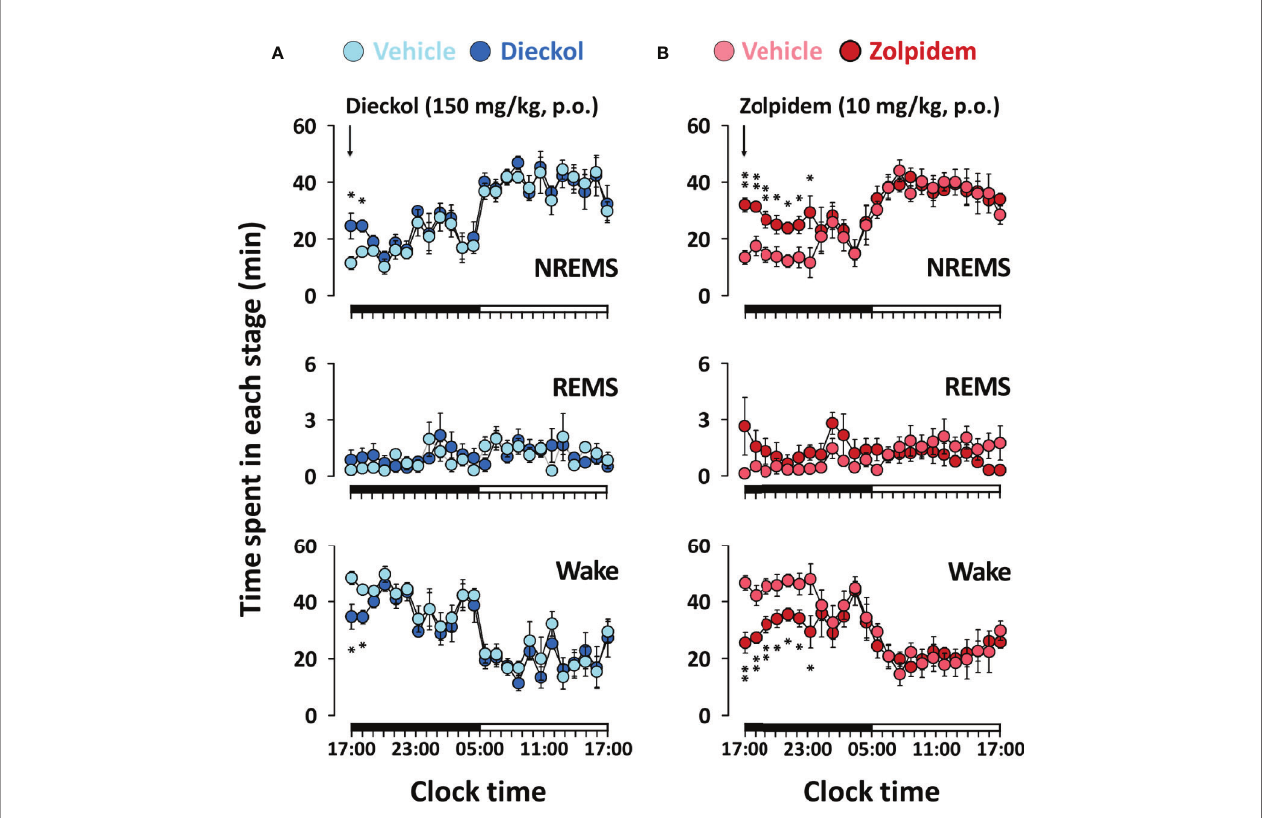
FIGURE 4 | Effects of dieckol (A) and zolpidem (B) on time-course changes in NREMS, REMS, and Wake for 24 h in C57BL/6N mice. Light and dark circles indicate the baseline day (vehicle) and experimental day (dieckol or zolpidem), respectively. Each circle represents the hourly mean ± SEM (n = 6 – 7) of NREMS, REMS, and Wake. * p < 0.05 and ** p < 0.01, signi fi cant difference compared to the vehicle (two-way ANOVA with Bonferroni post-test). NREMS, non-rapid eye movement sleep; REMS, rapid eye movement sleep; Wake,